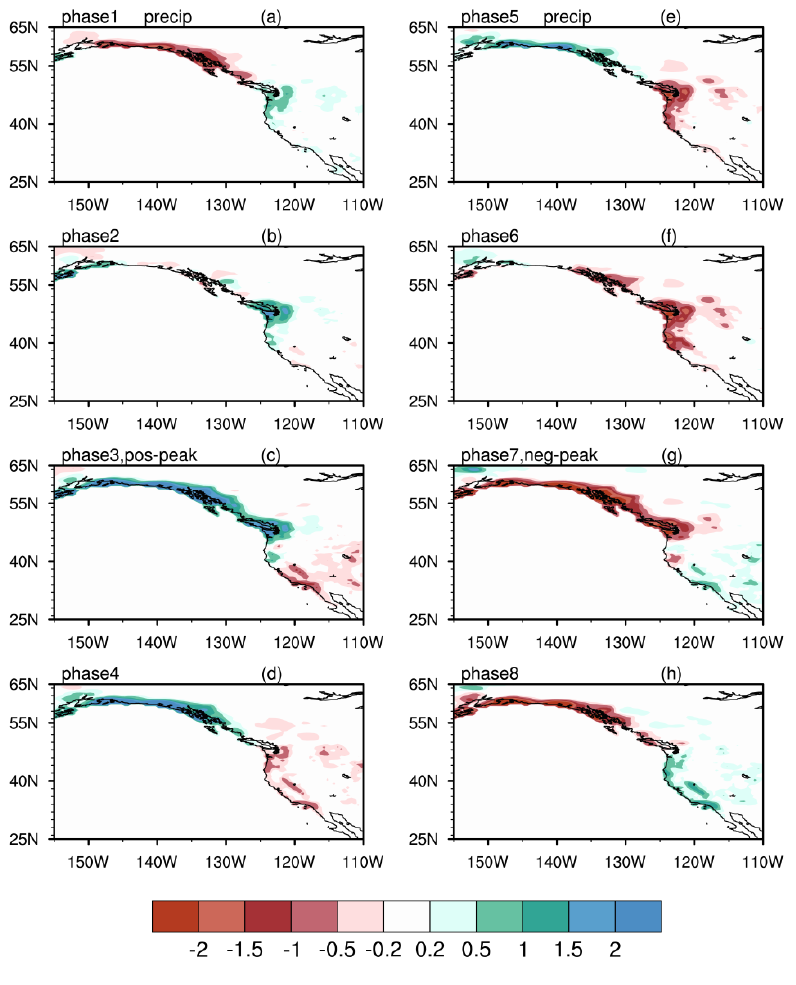
Figure 9. As in Figure 3, but for precipitation anomalies (mm day −1 ) over northwestern North America. ( a ) to ( h ) corresponding to phases 1 to 8.